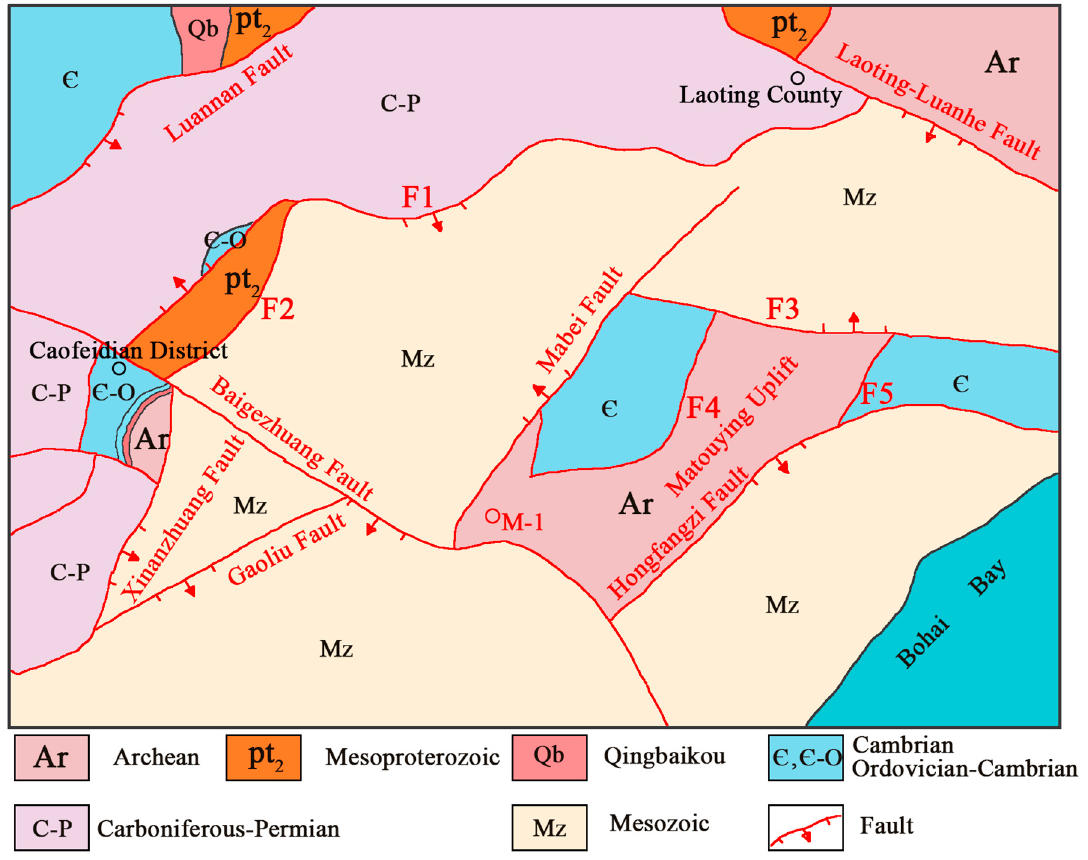
Figure 1. Tectonic location of the study area. The EGS project in the Matouying uplift is located in southern Dazhuanghe Village, Caofeidian District, Tangshan City. This project consists of injection well M-1 and produc- tion well M-2, which are about 200 m apart. Well M-1 has a final hole depth of 4502.11 m, with the water filtering interval at a depth of 4188.08–4502.11 m. This well has a